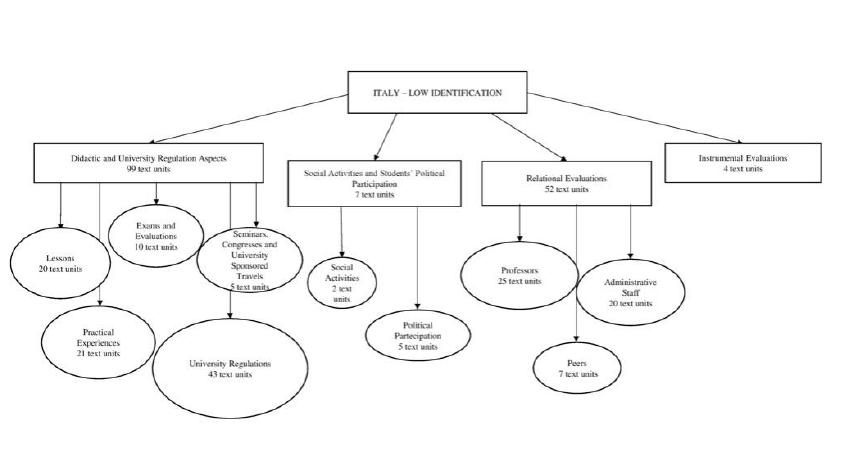
Concept map concerning Italian students in the condition of low identification N = 103; text units = 162